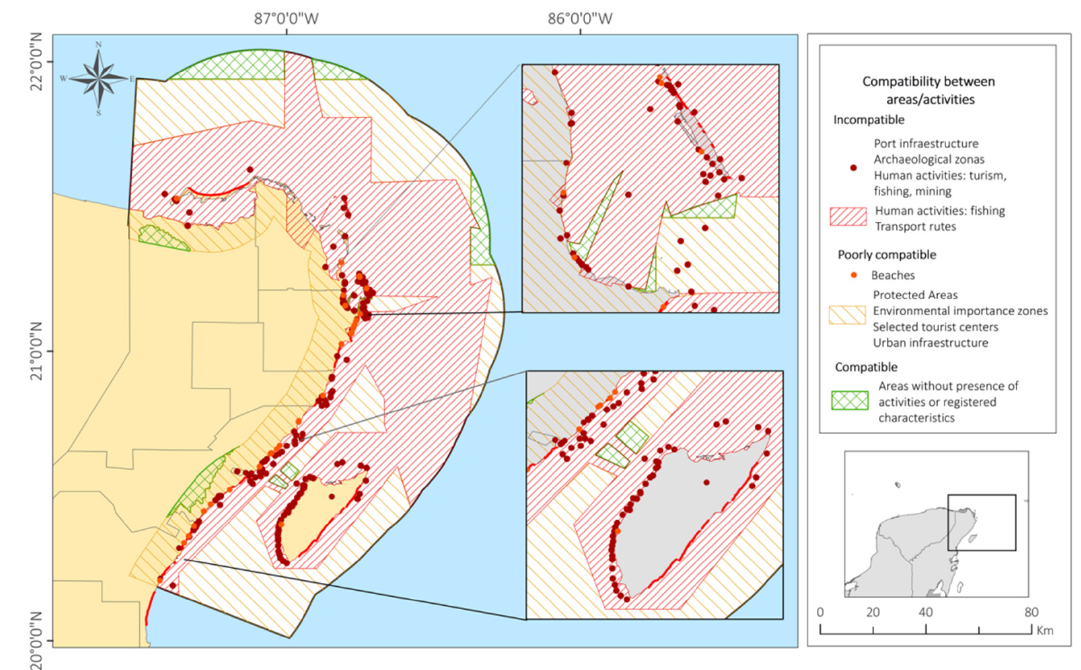
Figure 9. Compatibility Map.